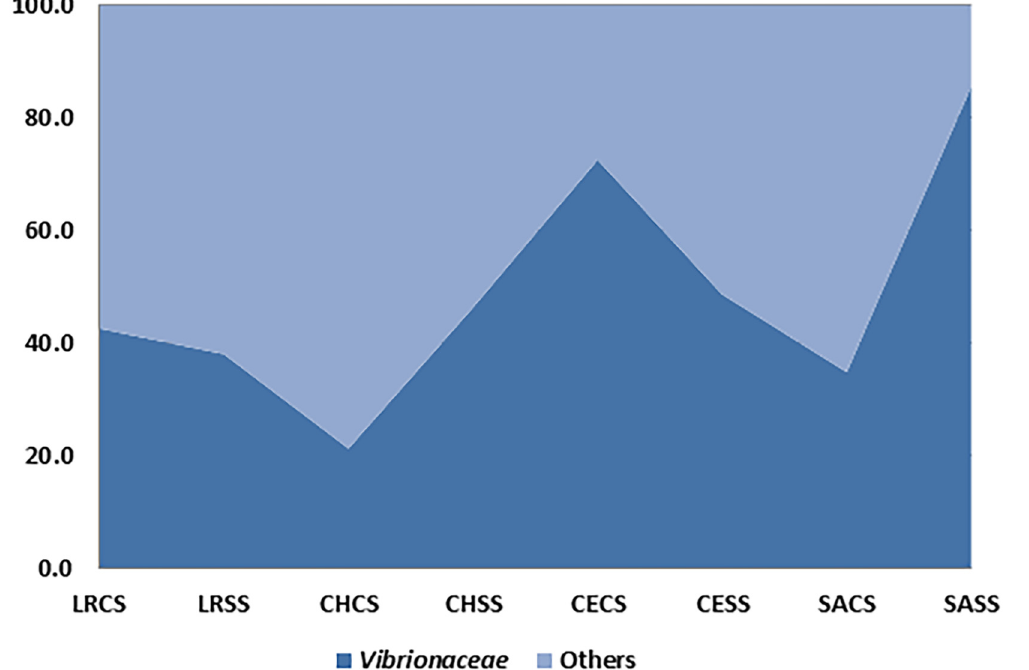
Fig 3. Effectiveness of the culture medium for the isolation of the family Vibrionaceae in four coastal lagoons: Rosada lagoon (LR); Chelem (CH); Celestun (CE) and Sabancuy (SA). CS (water samples cultured in tryptone soya broth + 3% NaCl). SS (water samples cultured in tryptone soy broth).